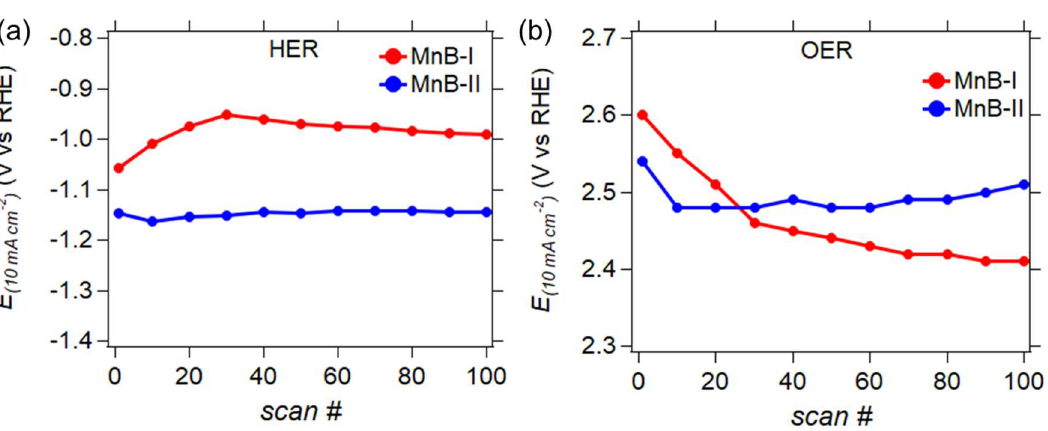
Figure 11. Potentials at +10 A∙m −2 ( E ( J = −10 A m−2) ) vs. consecutive LSV scan number ( scan # ), demonstrating the stability of the response over 100 scans for ( a ) HER and ( b ) OER.